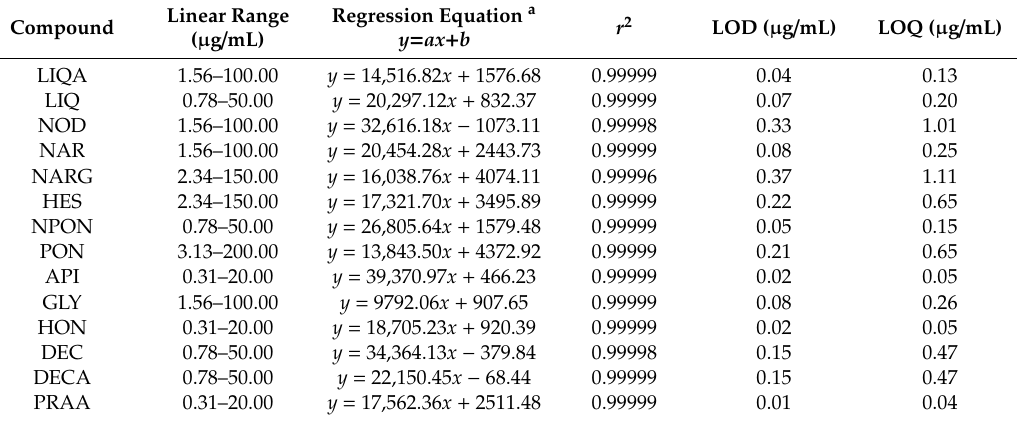
Table 1. Linear range, regression equation, r 2 , limit of detection (LODs), and limit of quantification (LOQs) for marker compounds using high-performance liquid chromatography–photodiode array detection (HPLC–PDA) ( n =